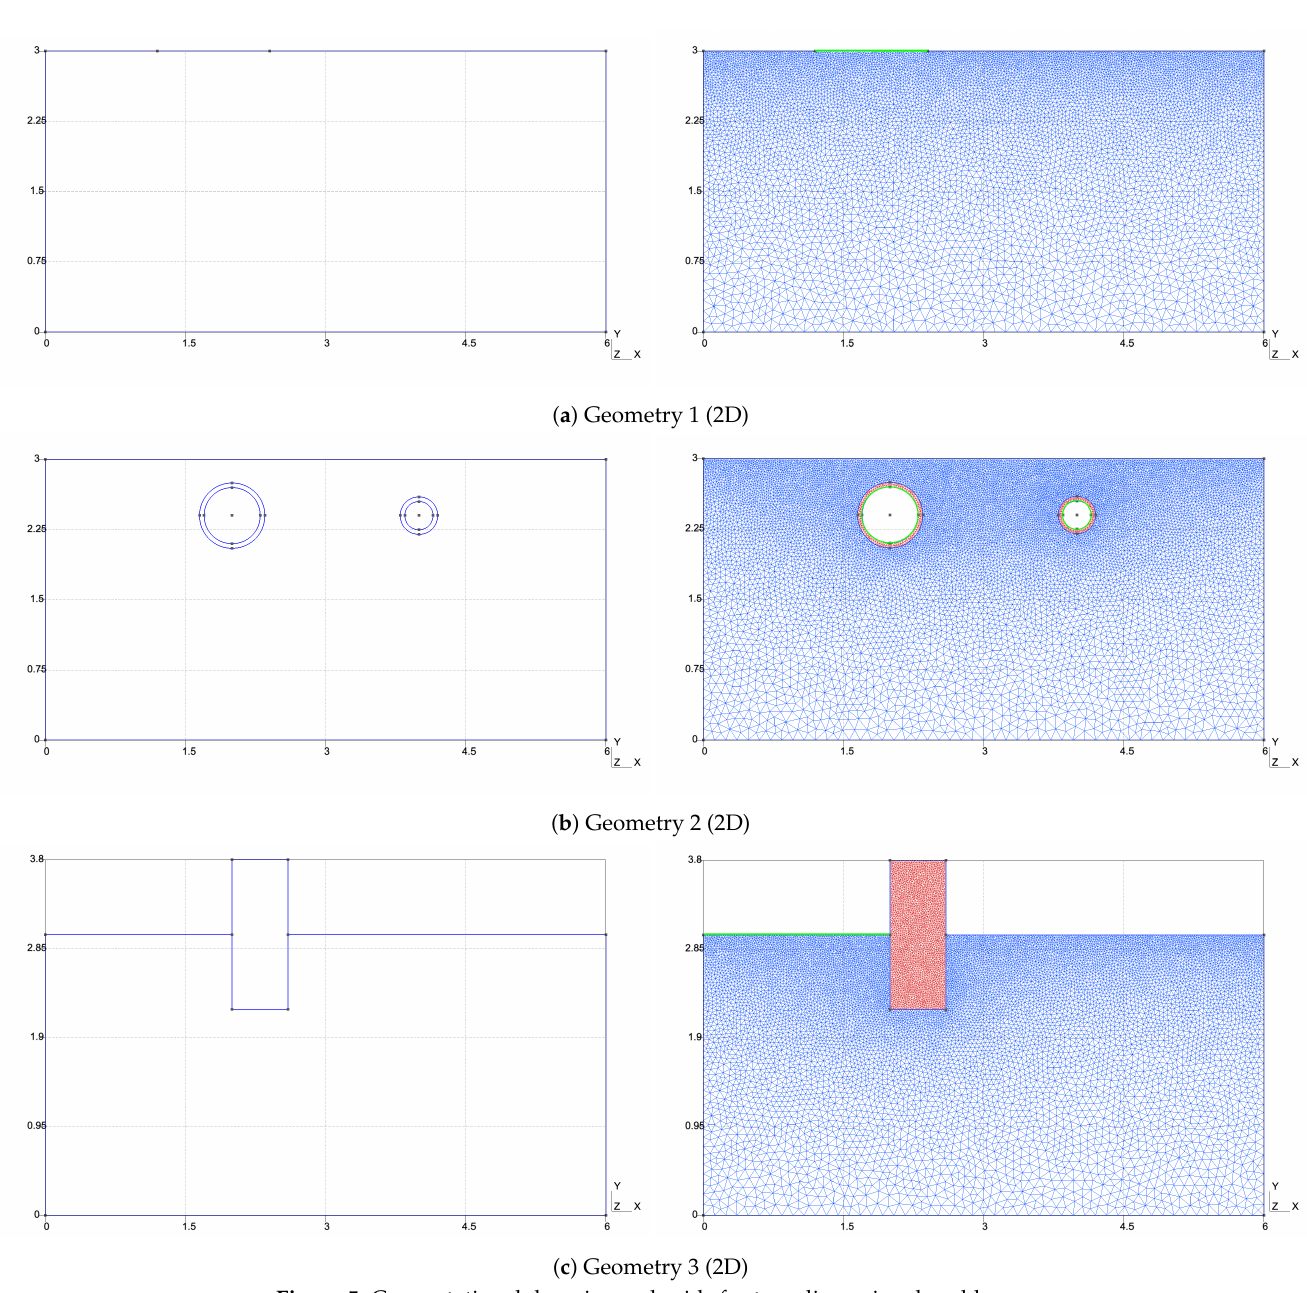
Figure 5. Computational domains and grids for two-dimensional